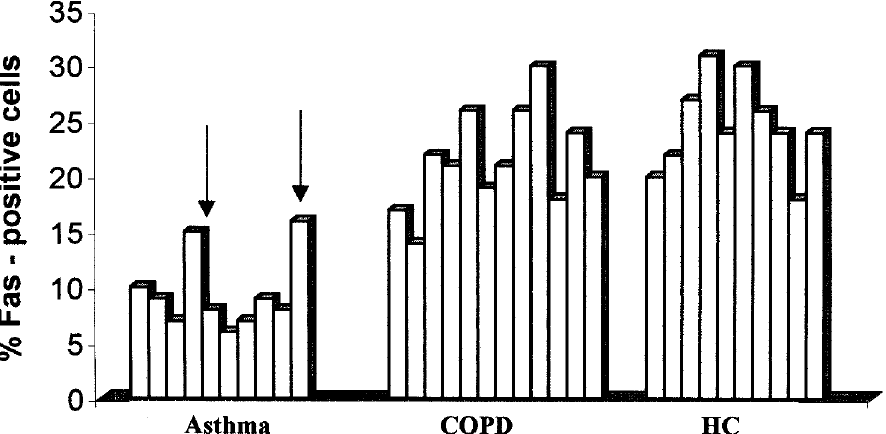
FIG. 3. Expression of Fas in induced sputum mononuclear cells from 10 patients with asthma, 12 patients with COPD, and 10 healthy controls (HC). Individual values were expressed in percentage (number of Fas-positive cells/number of mononuclear cells 3 100). Asthmatic patients number 4 and 10 [ ® ], have subnormal values of Fas-positive cells. According to Table 2, they have low values of